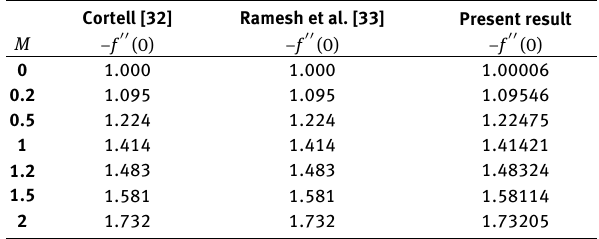
Table 1: Comparison results for the function − f (cid:48)(cid:48) (0) for several val- ues of M in the case, We = 0, and n = 0, (absence of temperature and concentration).